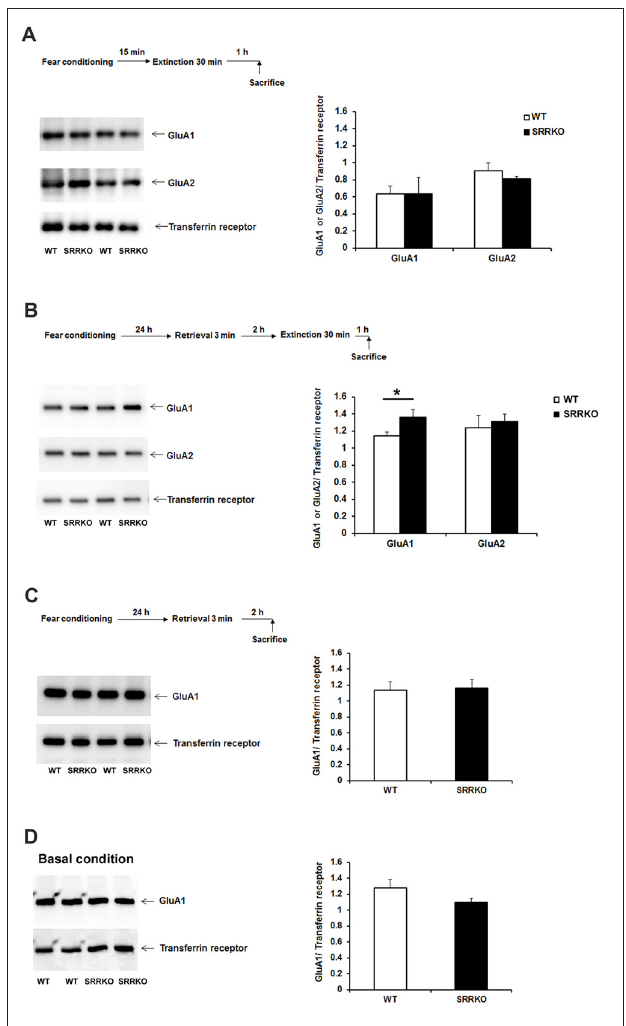
FIGURE 5 | SRRKO mice express higher levels of α -amino-3-hydroxy-5-methyl-4-isoxazolepropionic acid-type glutamate receptor (AMPAR) GluA1 subunit in the synaptic membrane than do WT mice after P-RE. (A) Expressions of AMPAR GluA1 and GluA2 subunit in the hippocampal synaptic membrane fraction 1 h after IE were comparable between WT ( n = 3) and SRRKO ( n = 3) mice. (B) Expressions of the GluA1 and GluA2 subunit in the hippocampal synaptic membrane fraction 1 h after P-RE. SRRKO mice exhibited significantly higher levels of GluA1 subunit in the synaptic membrane fraction than did WT mice ( n = 4, ∗ p < 0.05). (C,D) WT and SRRKO mice showed similar levels of GluA1 in the synaptic membrane fraction of the hippocampus 2 h after retrieval (C) or under basal conditions (D) . Data are presented as means ±